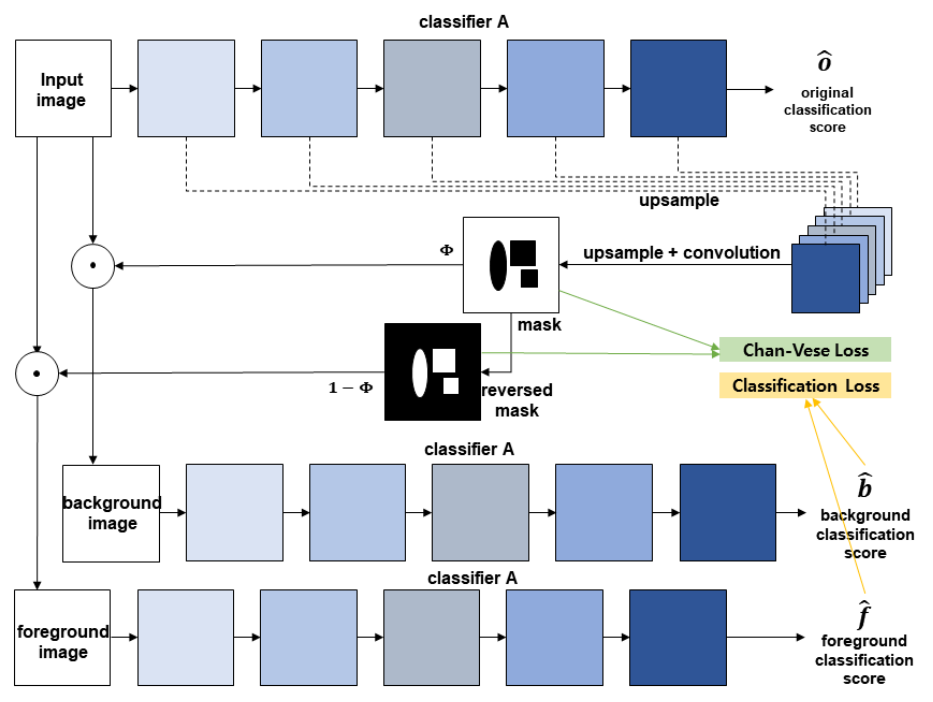
Figure 1. Illustration of the first network when the loss is composed of Chan–Vese energy function.